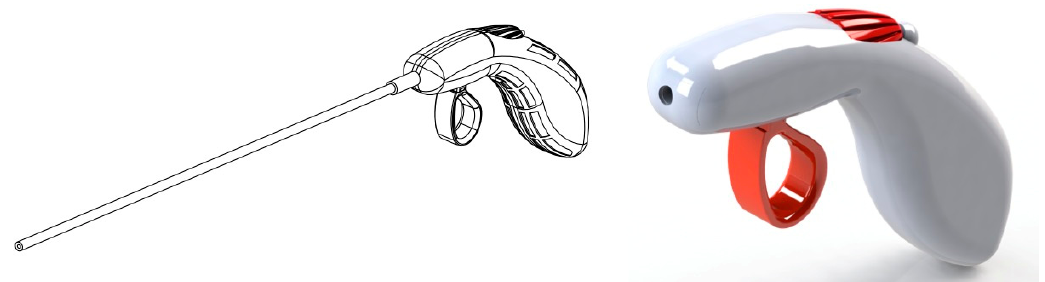
Figure 1. Design of the laparoscopic instrument handle (patent EP2471473A1) developed in the ERGOLAP project.